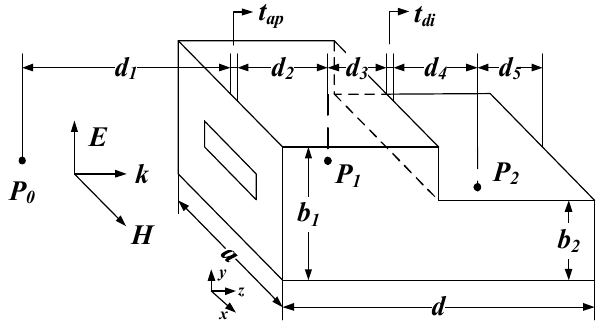
Figure 1. Physical model of irregular shielded cavity irradiated by plane waves.